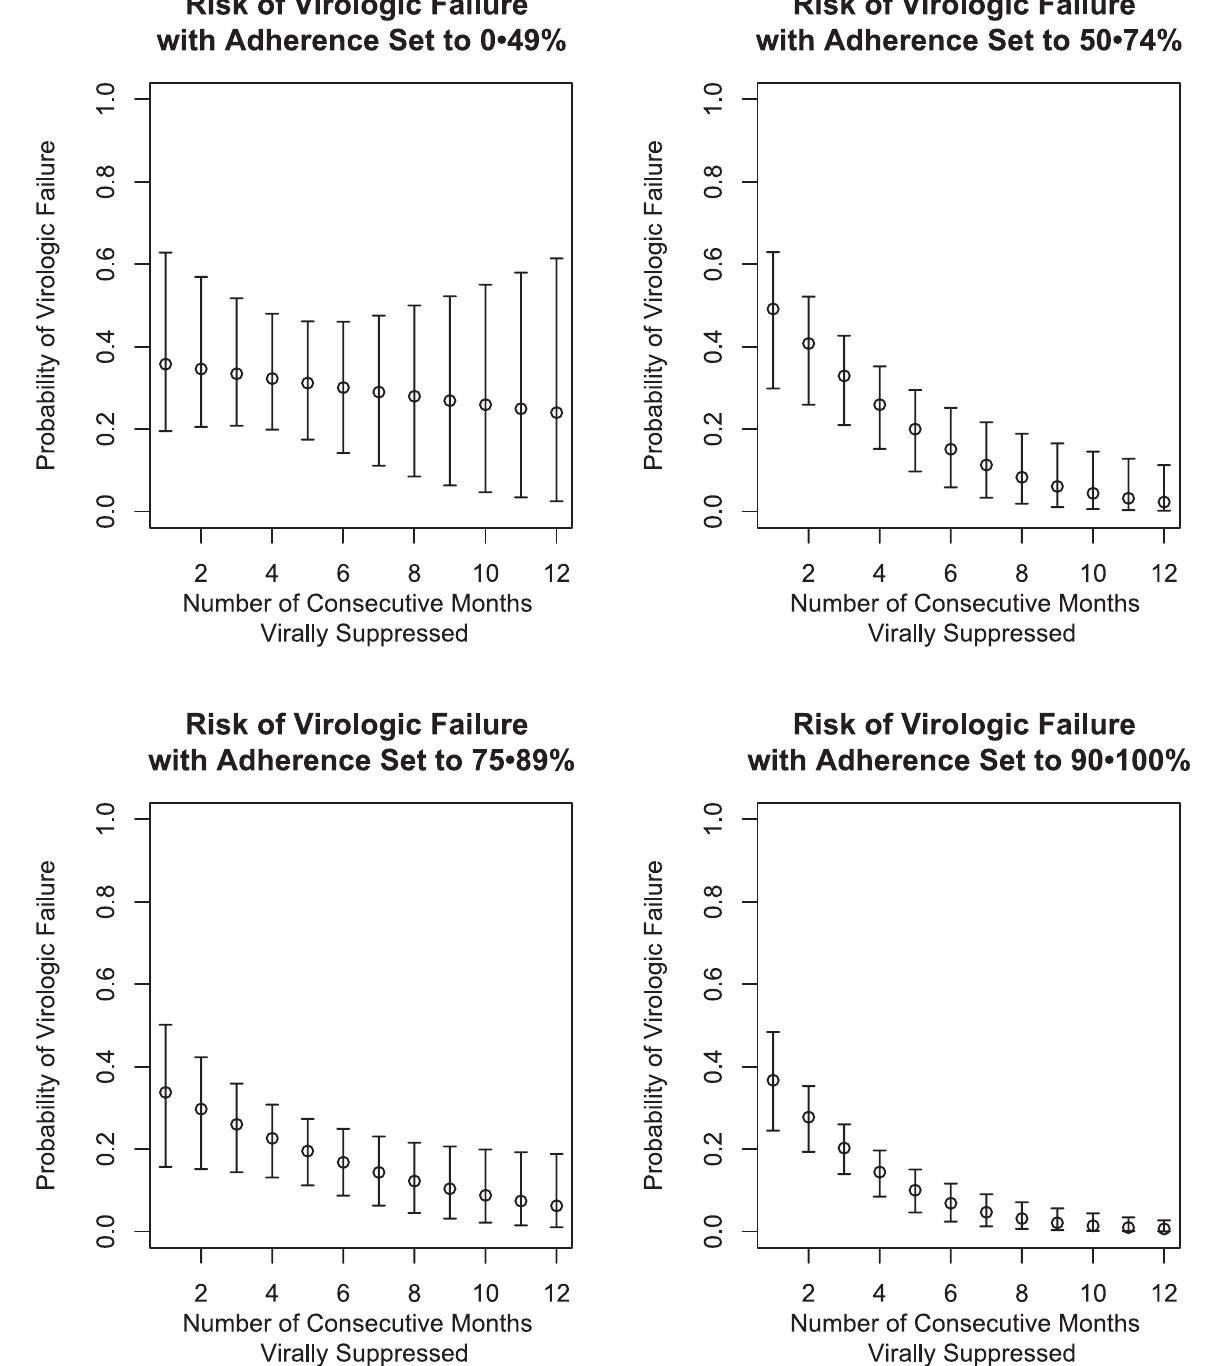
Figure 1. Estimates and 95% Confidence Intervals for the Risk of Virologic Failure, at Four Ranges of Adherence, Given Duration of Continuous Viral Suppression.